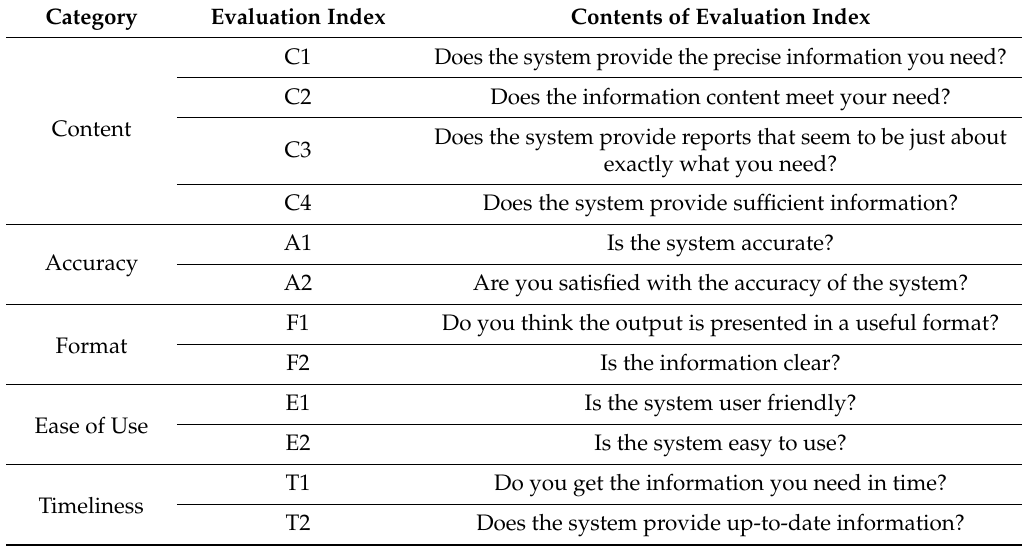
Table 3. Evaluation index for measuring End-User Computing Satisfaction